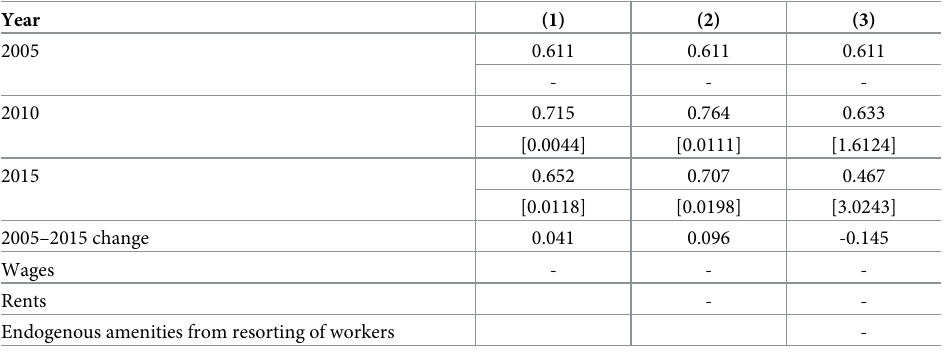
Table 10. Welfare inequality decomposition from 2005 to 2015, with migration costs eliminated: Wages, rents, and amenities.